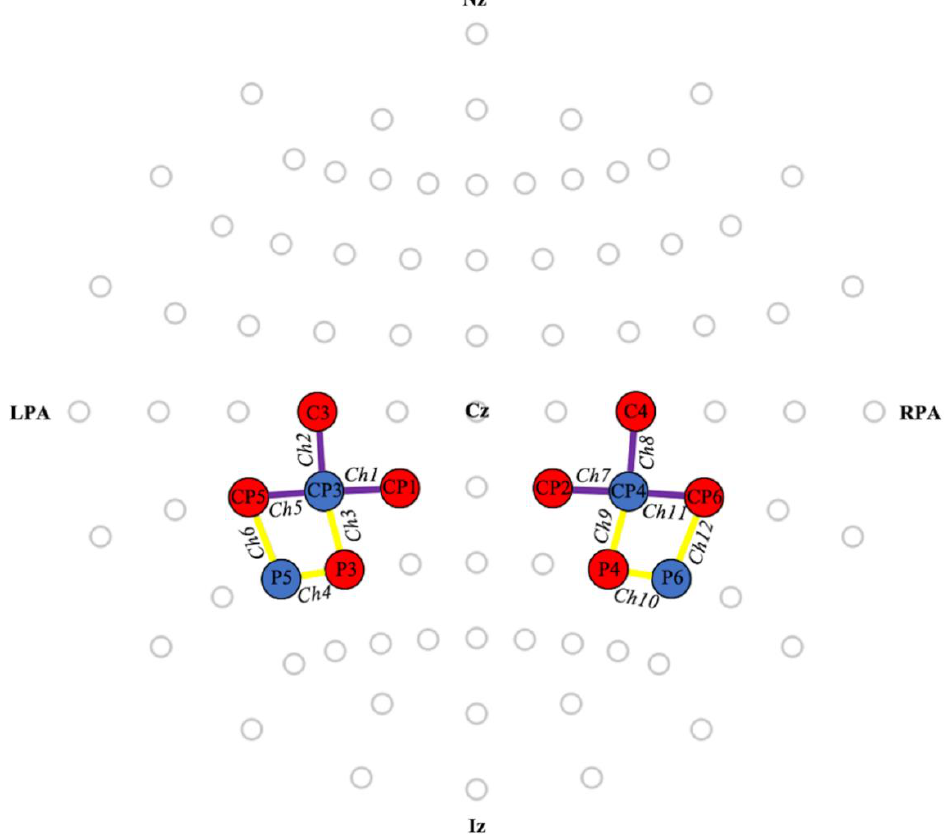
Figure 1. Locations of optodes and channels relative to the 10/10 international system. Detectors and sources are shown in blue and red, respectively. BA40 ( purple ) included channels 1, 2, and 5 on the left hemisphere and 7, 8, and 11 on the right hemisphere. BA39 ( yellow ) included channels 3, 4, and 6 on the left hemisphere and 9, 10, and 12 on the right hemisphere. Ch: Channel. Cz: Vertex. Iz: Inion. LPA: Left pre-auricular. Nz: Nasion. RPA: Right pre-auricular.